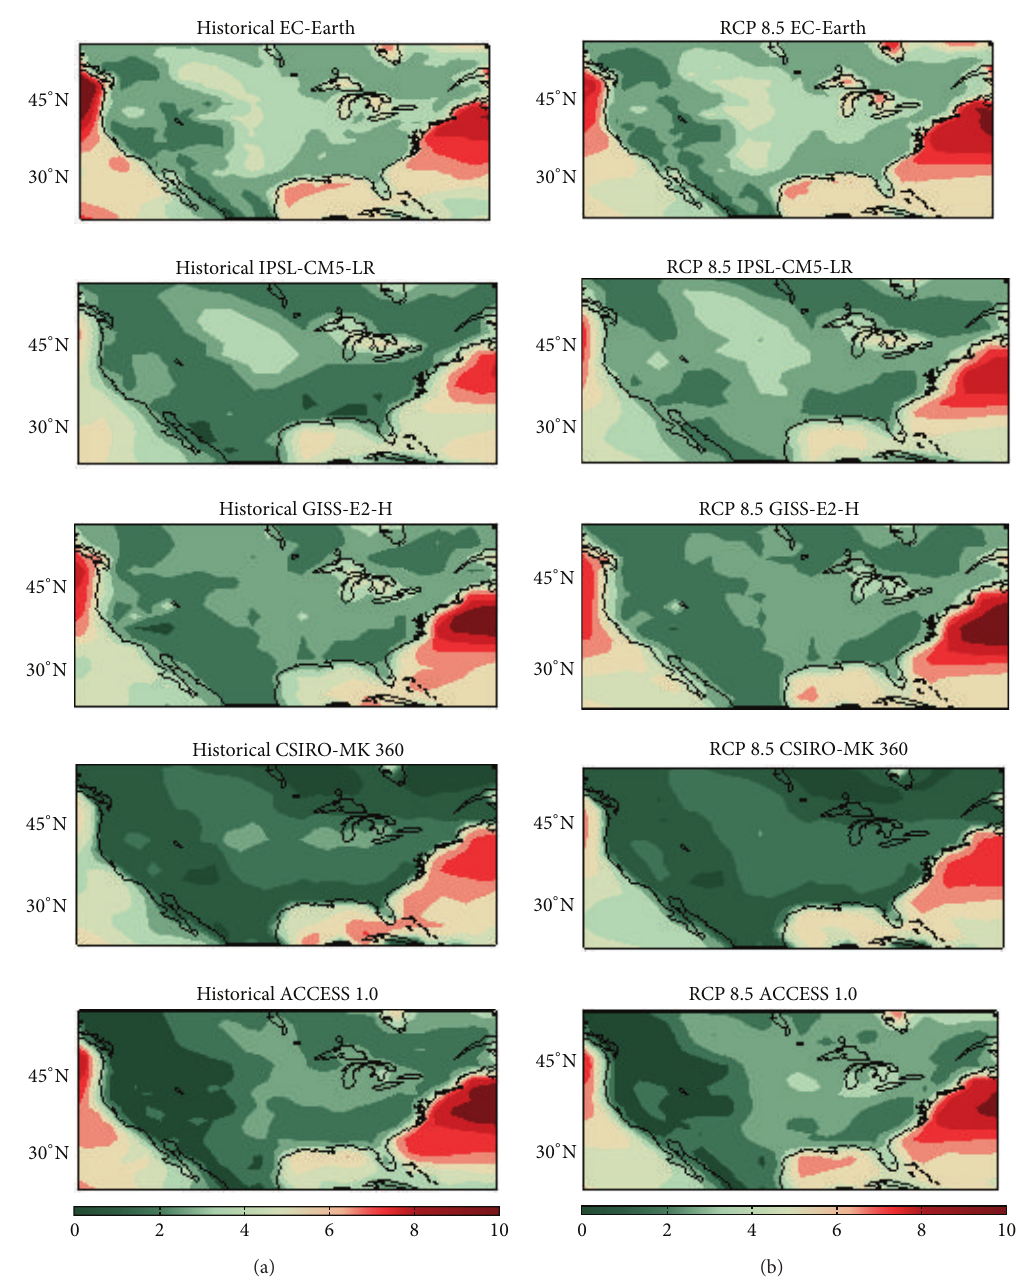
Figure 1: The climatology of surface wind speed over North America for winter (DJF) from the 20th century historical runs (a) and 21st century RCP 8.5 runs using five CMIP5 models as labeled at the top of each panel. The color scale, in m/s, is shown at bottom. Green and red colors represent lower and higher wind